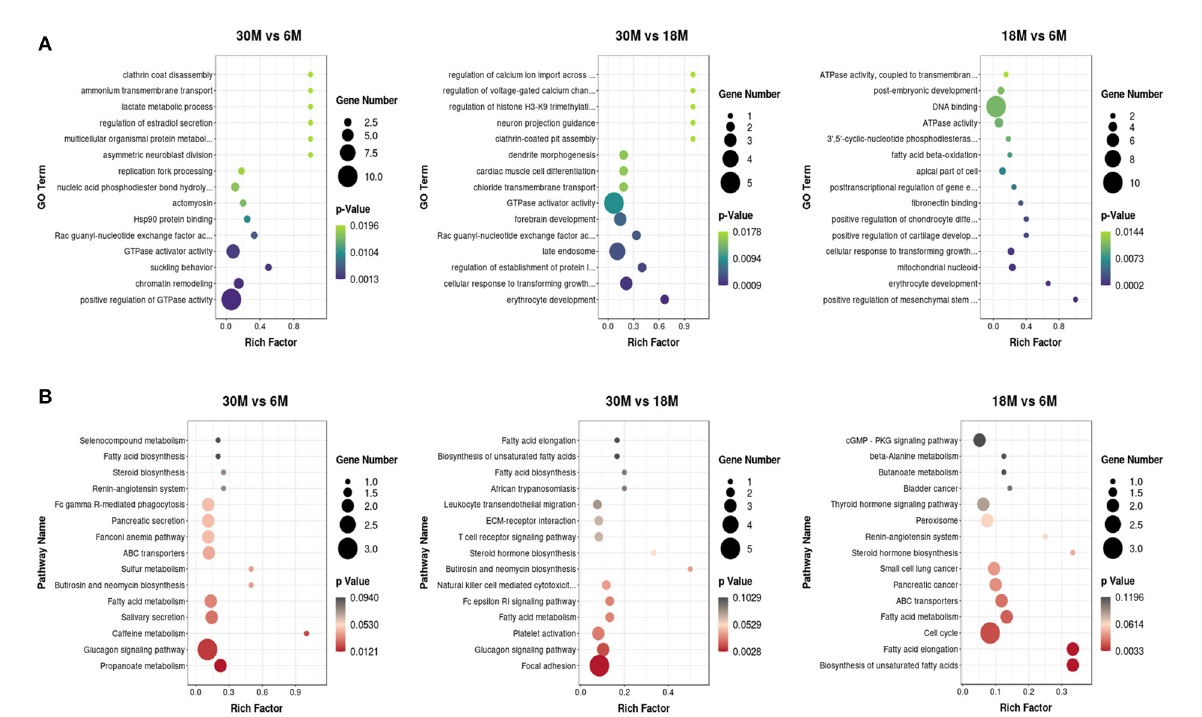
FIGURE6 The top 15 enriched GO and KEGG terms for DE circRNAs. (A) GO analysis; (B) KEGG